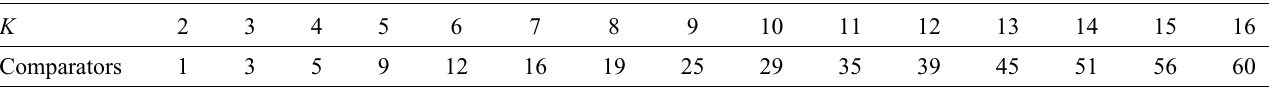
TABLE III. The number of comparators needed for a quantum sort of K items. Each comparator involves an inequality test and a controlled swap. The number of comparators for a given K is denoted St ( K )